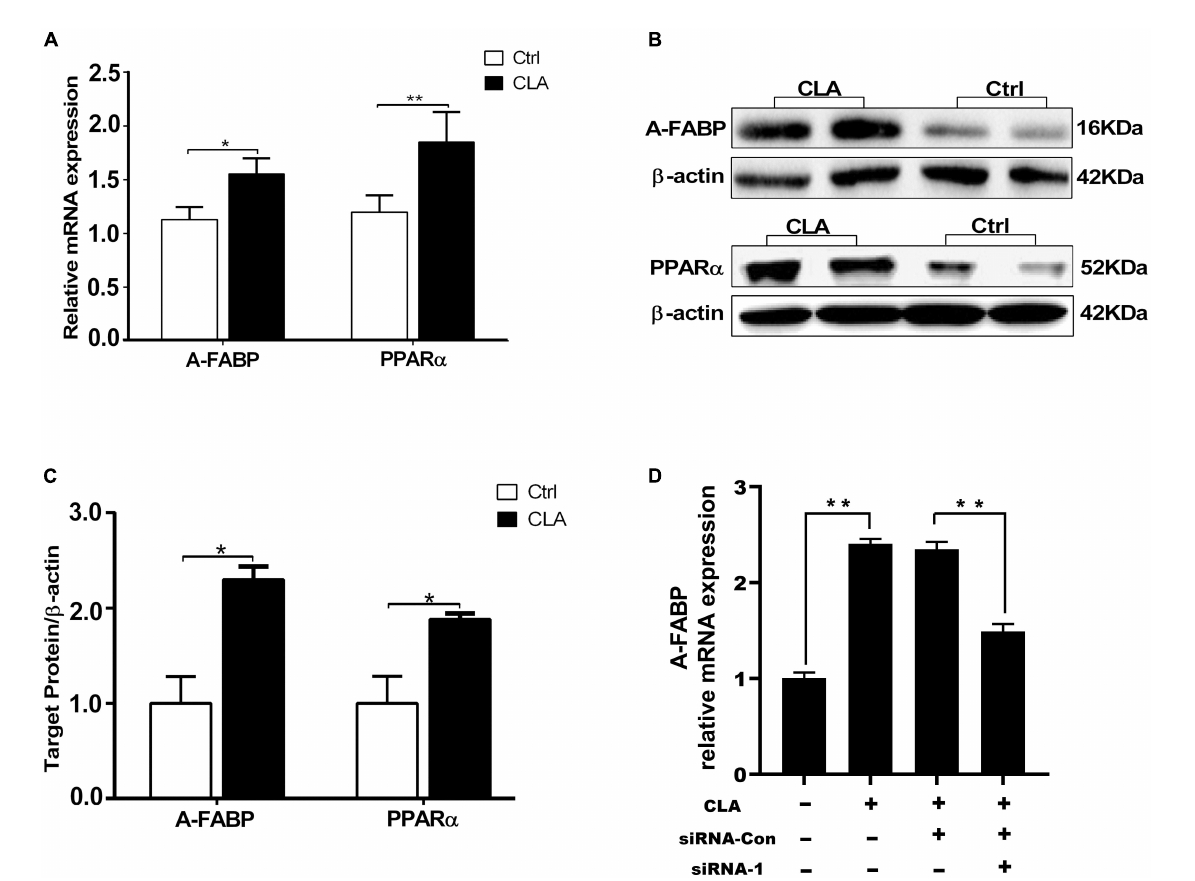
FIGURE4 Dietary CLA up-regulated A-FABP and PPAR α expression in the quadriceps femoris of mice. (A–C) The total RNA from the quadriceps femoris of mice was extracted and RT-qPCR was performed to detect the mRNA levels of A-FABP and PPAR α (A) , and GAPDH was used as internal reference gene. RT-qPCR was analyzed using the cycle threshold (2 − (cid:77)(cid:77) CT ) method. Western blotting was performed to measure the protein level of A-FABP and PPAR α (B) , and the relative level of A-FABP and PPAR α was analyzed by Image J (C) . (D) SiRNA control (siRNA-Con) or siRNA-mediated knockdown of PPAR α expression (siRNA-1) was transfected into 3T3-L1 cells for 4 h, and was then stimulated with CLA (100 µ M) for 48 h. The A-FABP mRNA levels were measured by RT-qPCR. Data in panels (A,C,D) were analyzed by t -test. * P < 0.05, ** P <